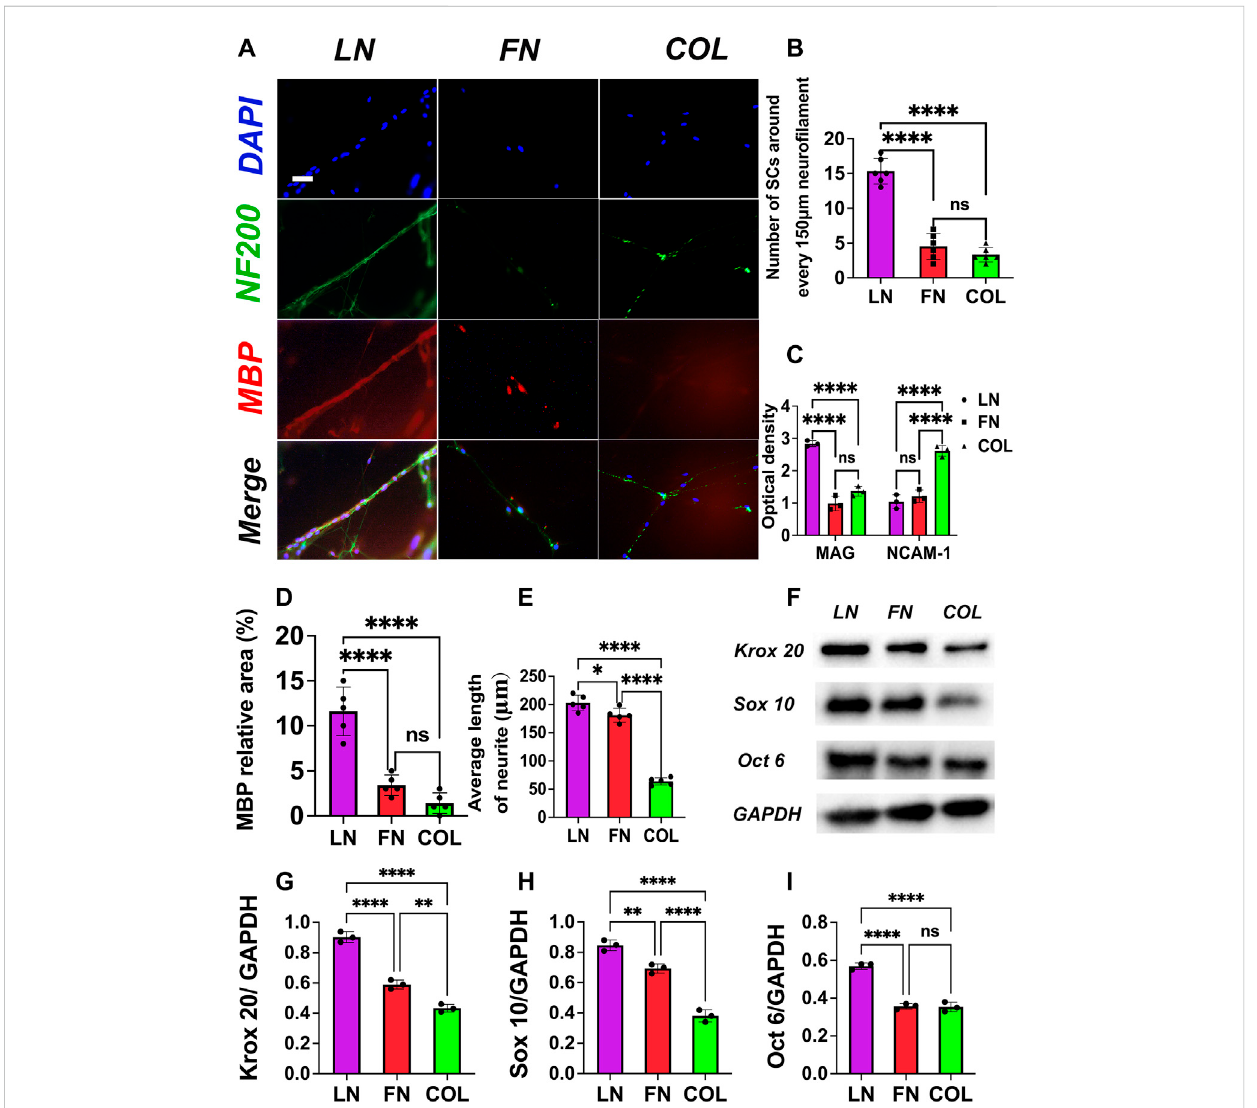
FIGURE 4 Immuno fl uorescence staining of SC DRG cocultures: NF-200 (green) and MBP (red) were used to identify neuro fi laments and myelin sheaths, respectively. Theneuro fi lamentsintheLNgroupwerethethickest,andalargenumberofSCswerearrangedaroundtheneuro fi laments (A) .Quantitative analysisshowedthatthenumberofSCsaroundneuro fi lamentsper150 μ mlengthintheLNgroupwassigni fi cantlymorethanthatintheFNgroupandIV Col group ( p < 0.0001) [ (B) , n = 6]. In the supernatant, the absorbance of MAG (Y-axis) signi fi cantly increased and NCAM-1 signi fi cantly decreased ( p < 0.05) [ (C) , n = 3], suggesting a key role of LN in promoting myelin formation. In the FN group, both MAG and NCAM-1 levels were low, a fi nding that may be related to the local aggregation of FN, thus inhibiting myelination. The average relative area [ (D) , n = 5] of MBP-positive regions (colored red) and the average extension length [ (E) , n = 5] of DRG neuronal processes were measured. The Western blot analysis results (F) revealed the presence of transcription factors associated with myelin sheath formation. The expression of myelin-related transcription factors ( n = 3): Krox 20 (G) , Sox 10 (H) and Oct 6 (I) . * p < 0.05, ** p < 0.01, **** p < 0.0001, ns p > 0.05. One-way ANOVA with Tukey ’ s post-hoc test. Scale bar = 20 μ